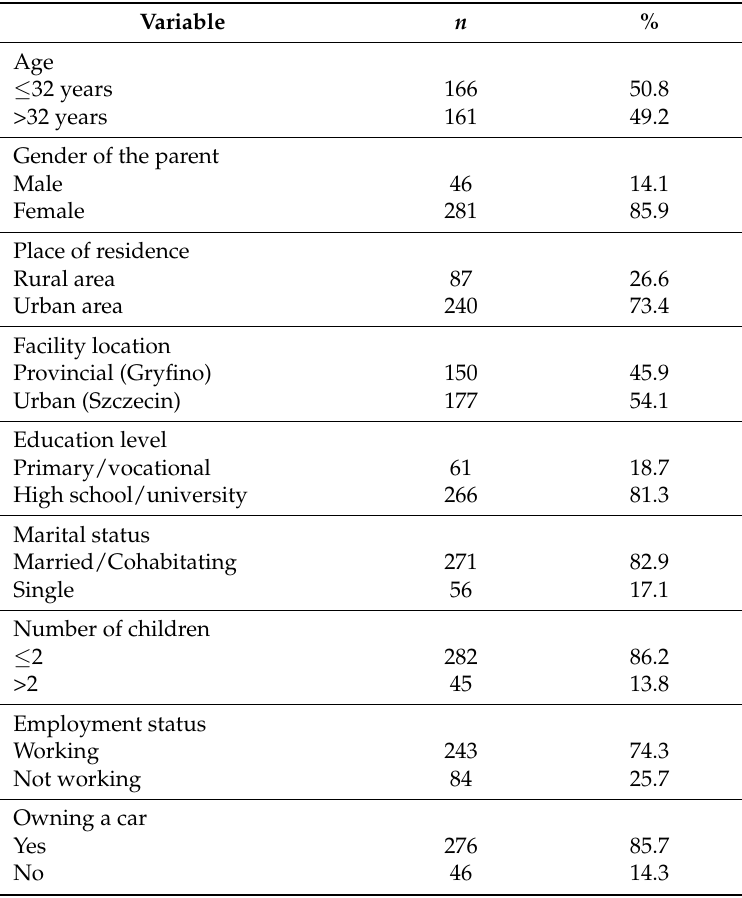
Table 1. Characteristics of parents of children up to five years old; Szczecin region, Poland; 2018, n = 327.